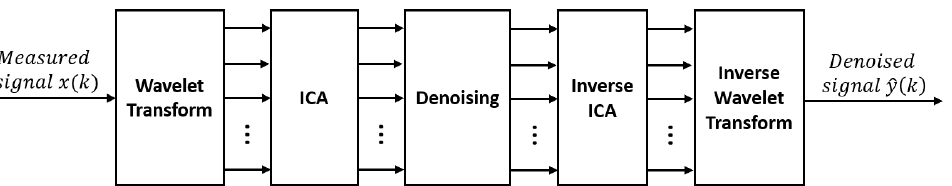
Figure 12. Block diagram of